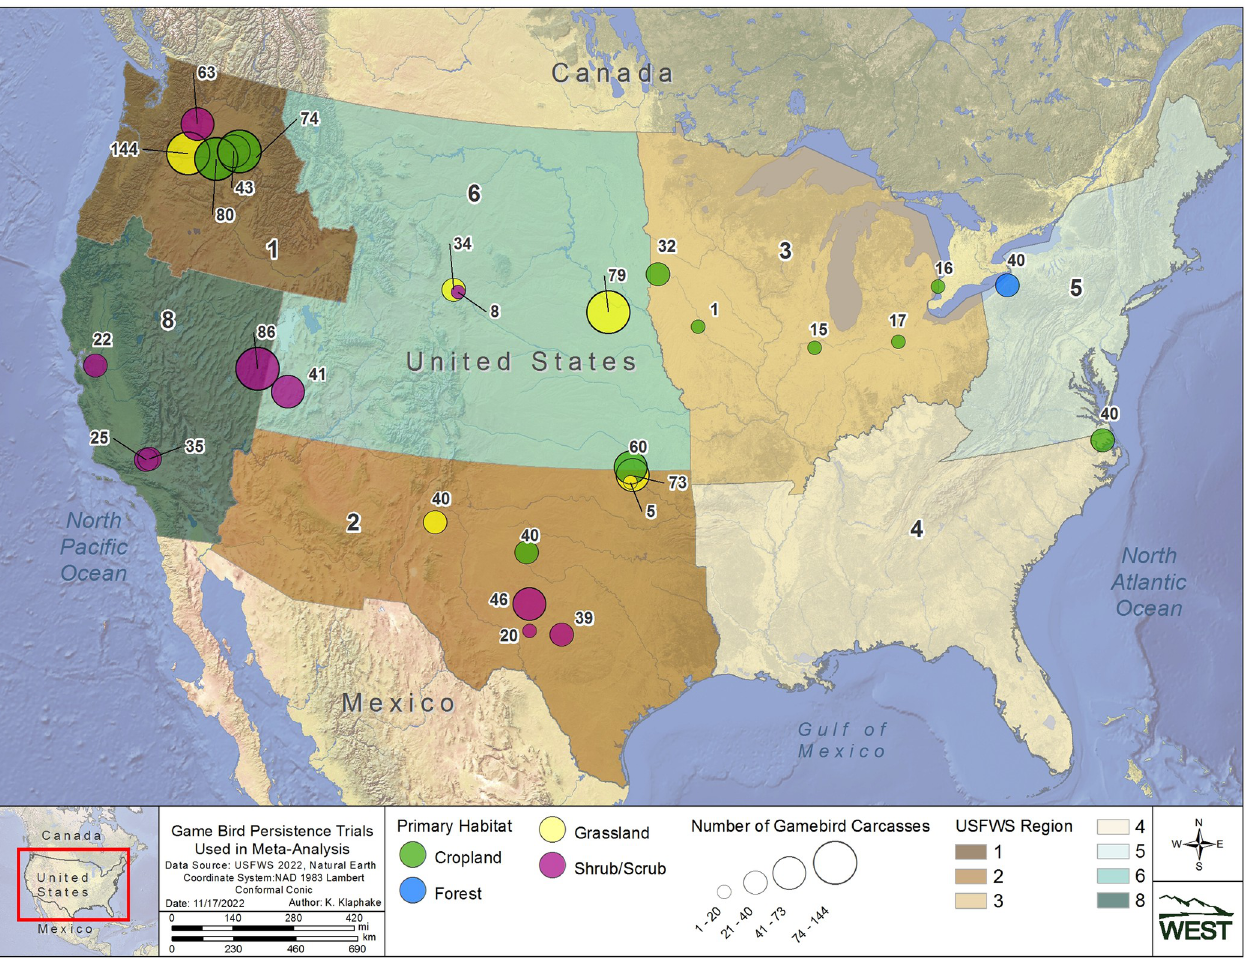
Fig 9. Locations of game bird carcass persistence trials included in the